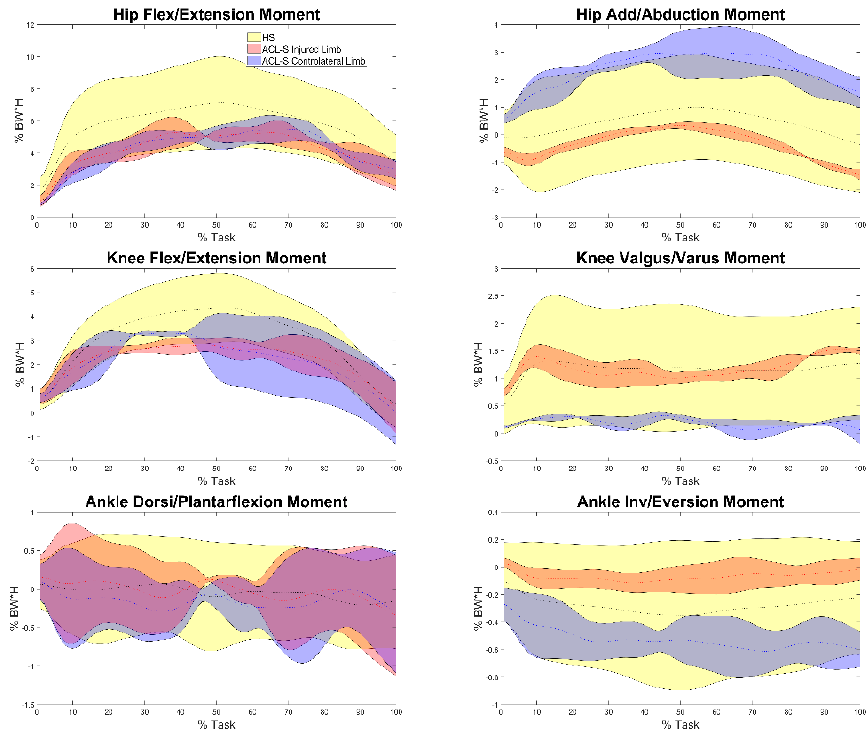
Figure A4. Hip, knee and ankle adduction/abduction and flexion/extension moments, calculated through theACL Quick Check ® : HS (yellow), ACL ‐ S injured limb (red) and ACL ‐ S contralateral limb (blue). Average plus and minus one standard deviation are reported as coloured bands. Average plus and minus one standard deviation are reported as coloured bands.